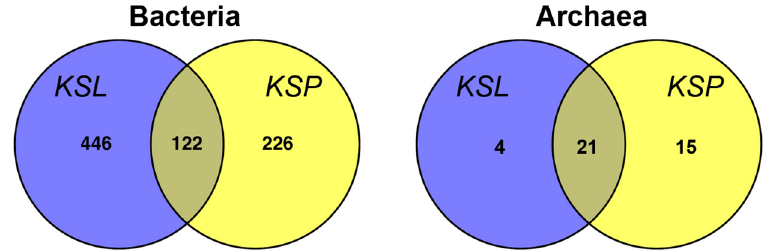
Figure 2. Venn diagrams of the shared and unique bacterial and archaeal operational taxonomic units in two water wells (KSL and KSP) of the Lake Karla Basin,